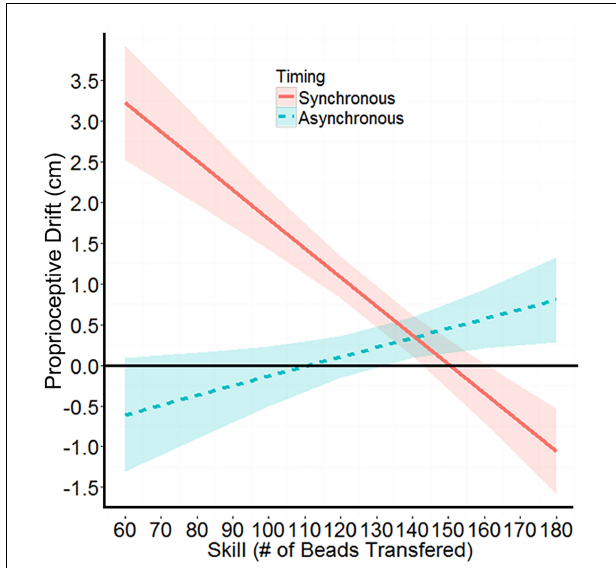
FIGURE 4 | The significant interaction between the timing of visuo-tactile stimulation, and the number of beads transferred during the tool-skill task. Shaded areas indicate ± 1 SEM.